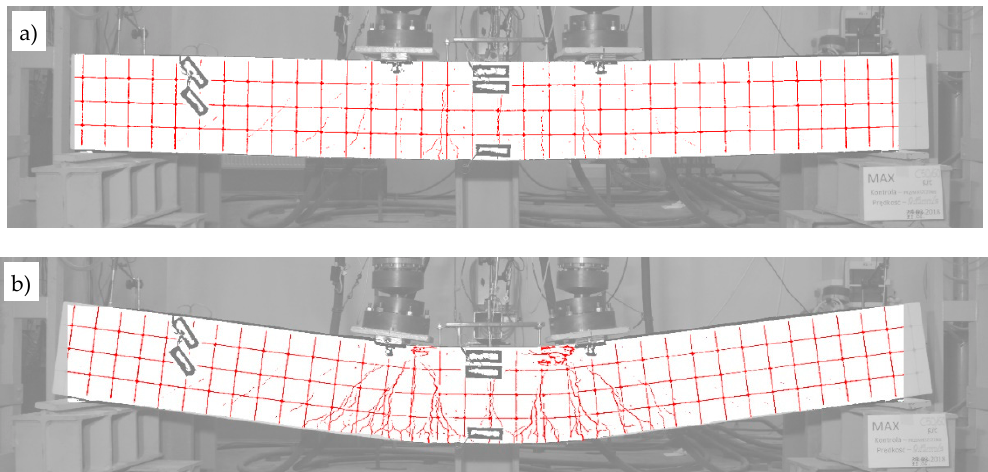
Figure 35. Views of the cracking of beam #2: ( a ) the neutral axis reaches the layer boundary according to Equation (10) ( z c = 7 cm); ( b ) the actuators reach the maximum travel range. In order to increase the clarity of the figure, the instrumentation and the places where the strain gauges were glued are painted in grey, and the positioning grid (10 cm mesh) and cracks are marked in red.